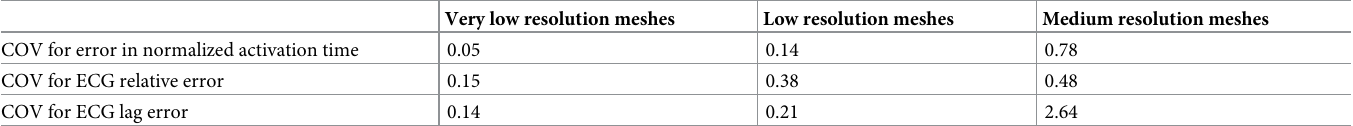
Table 4. Discretization error coefficients of variation (COV), across patients, using different resolution meshes (columns) for normalized apex-to-base activation time and simulated ECG. Very low resolution meshes Low resolution